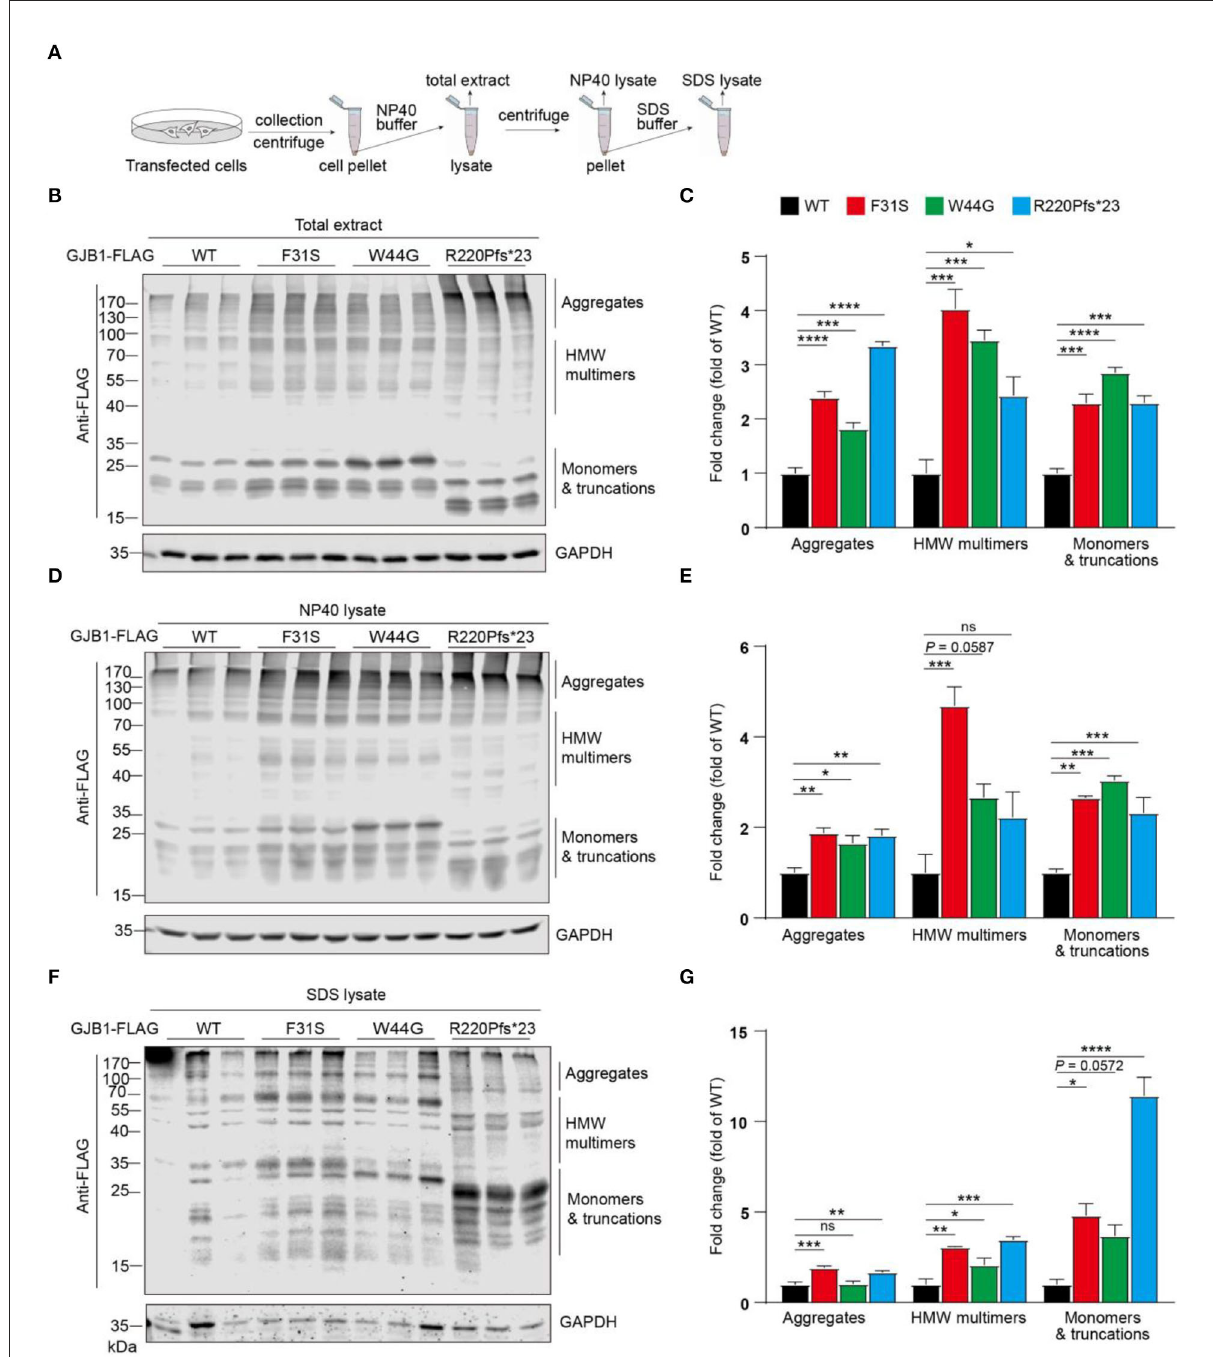
FIGURE4 Sequential extraction analysis of GJB1 in overexpressing cells. (A) Illustration of stepwise extraction using NP40 buffer and SDS buffer to obtain a total extract, NP40 lysate, and SDS lysate. GJB1-transfected cell pellets were lysed in NP40 buffer for total extract collection. The supernatant was collected as N40 lysate after centrifugation. Pellet was then lysed and sonicated in SDS buffer to obtain SDS lysate. (B) Immunoblots of total extracts of cells expressing GJB1 variants using anti-FLAG antibody. HMW, high molecular weight. (C) Quantification of immunoblots in B. (D) Immunoblots of NP40 lysate of cells expressing GJB1 variants. (E) Quantification of immunoblots in D. (F) Immunoblots of SDS-lysate of cells expressing GJB1 variants. (G) Quantification of immunoblots in F. ns, not significant, * P < 0.05, ** P < 0.01, *** P < 0.001, **** P <